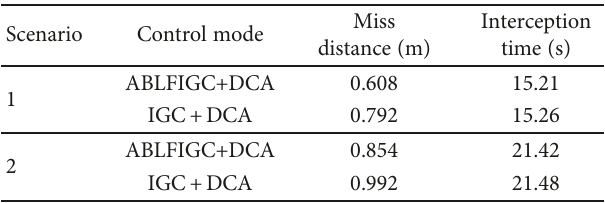
Table 2: Comparison of simulation results between the two scenarios.